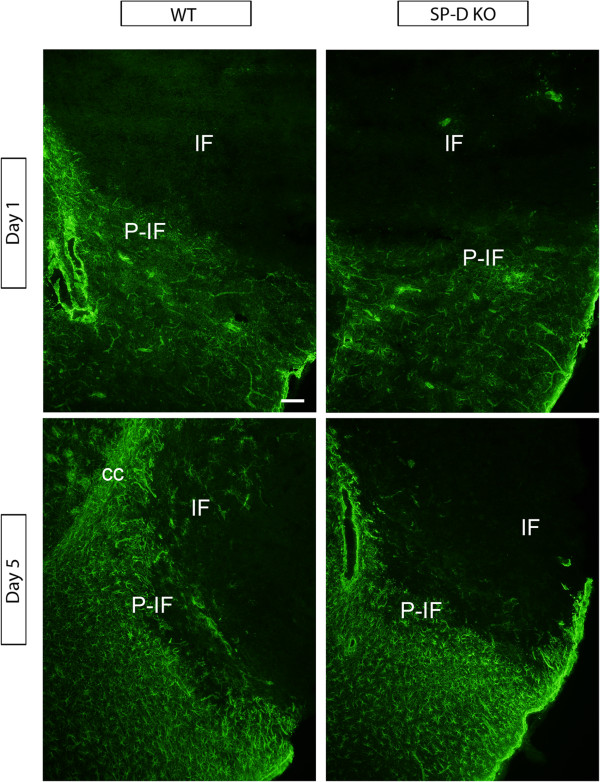
Astroglial reactions in surfactant protein-D (SP-D) knock out (KO) and wild type (WT) mice after permanent middle cerebral artery occlusion (pMCAO). Immunofluorescence photomicrographs of the infarct and peri-infarct in SP-D KO and WT mice 1 and 5 days after pMCAO showing similar astroglial response in SP-D KO and WT mice after pMCAO. cc: corpus callosum, IF: infarct, P-IF: peri-infarct. Scale bar: 100 μm.